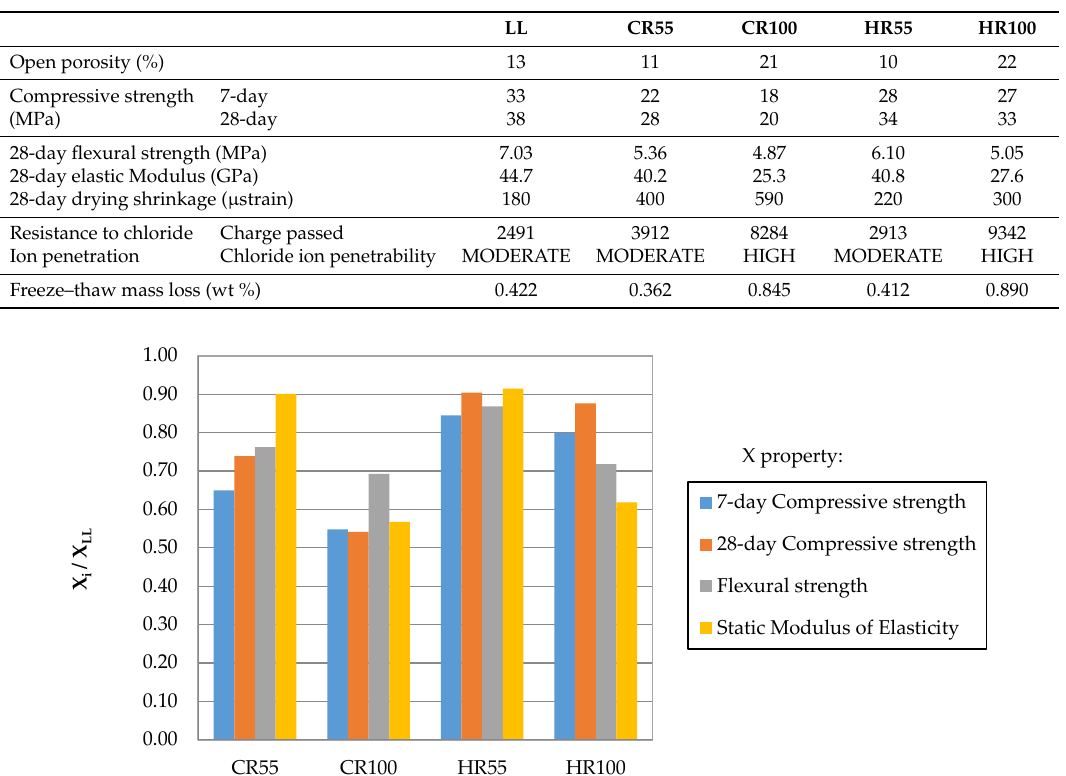
Table 5. Hardened concrete tests.